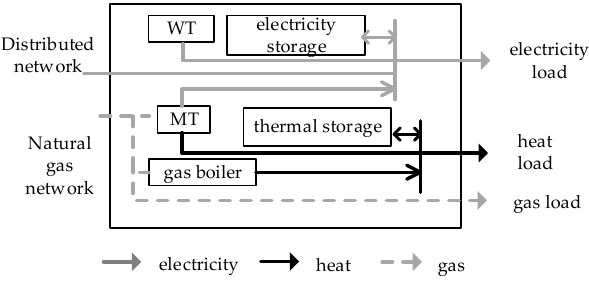
Figure 1. The structure of Regional Integrated Energy System.